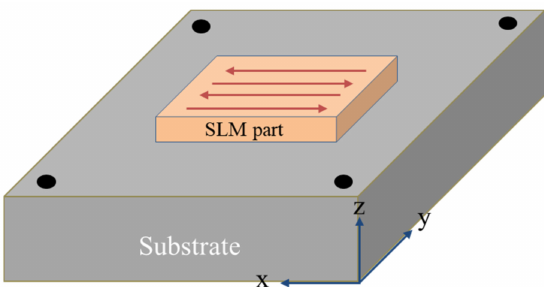
Figure 2. Schematic illustration of a selective laser melting (SLM)-fabricated low-alloy steel